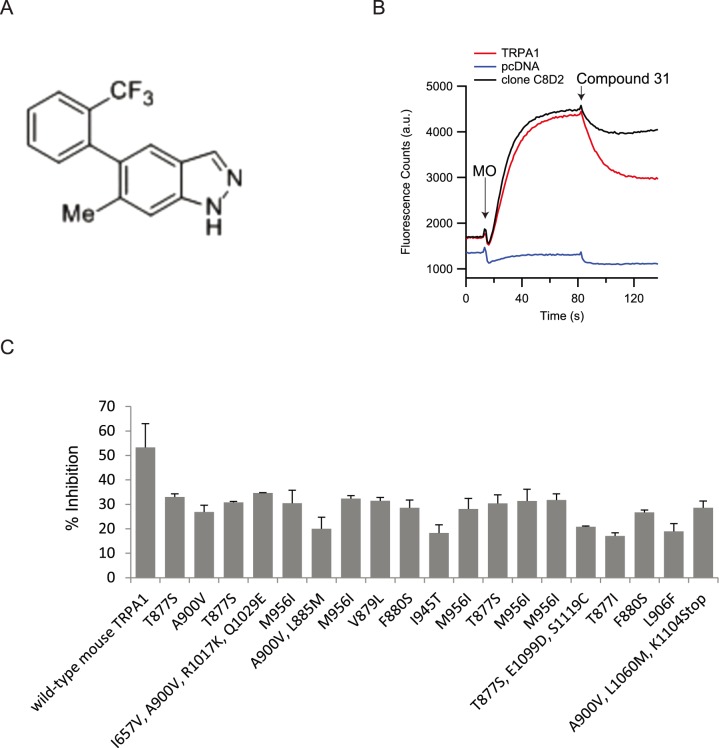
Screen for mutations affecting inhibition by Compound 31.A) Chemical structure of Compound 31 [13]. B) Activation of mouse TRPA1, an example of a mutant clone (clone C8D2; mutation A900V) with reduced inhibition by Compound 31 and pcDNA by 100 µM mustard-oil and subsequent inhibition of 1 µM Compound 31 (final concentrations). Curves are averages, n = 4. C) Average inhibition of mustard-oil (100 µM) induced responses by Compound 31 (1 µM) for 19 clones identified in the initial screen. Single-point mutations identified in each clone are annotated below. Error bars are stdv., n = 3 or 4 for each clone.